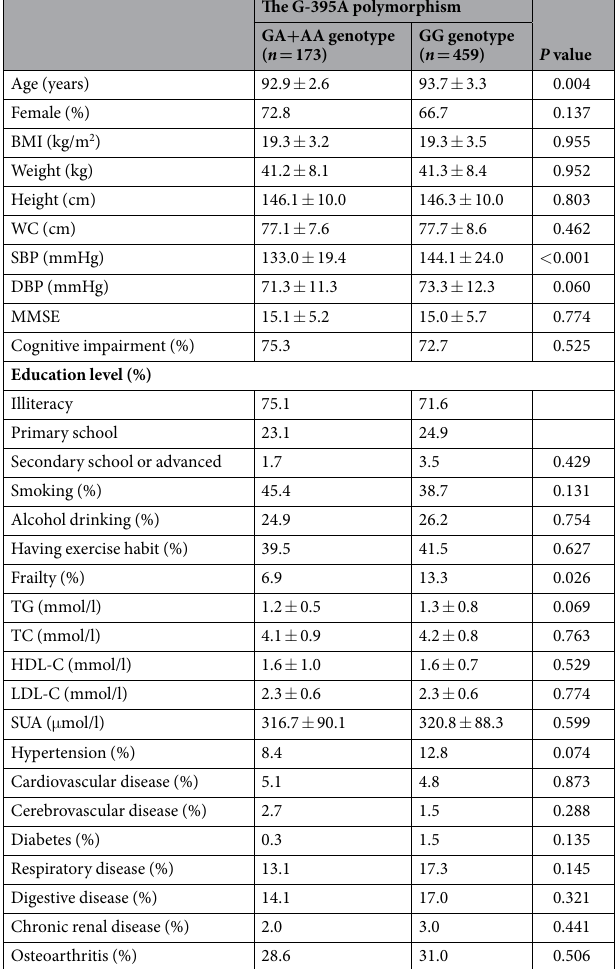
Table 2. Characteristics of the study population according to the G-395A polymorphism in the KL gene. Data are presented as the mean ± SD unless otherwise indicated. Abbreviations: BMI, body mass index; CAD, coronary artery disease; HDL-C, high-density lipoprotein cholesterol; LDL-C, low-density lipoprotein cholesterol; MMSE, mini-mental status examination; SUA, serum uric acid; TC, total cholesterol; TG, triglycerides; WC, waist circumference.